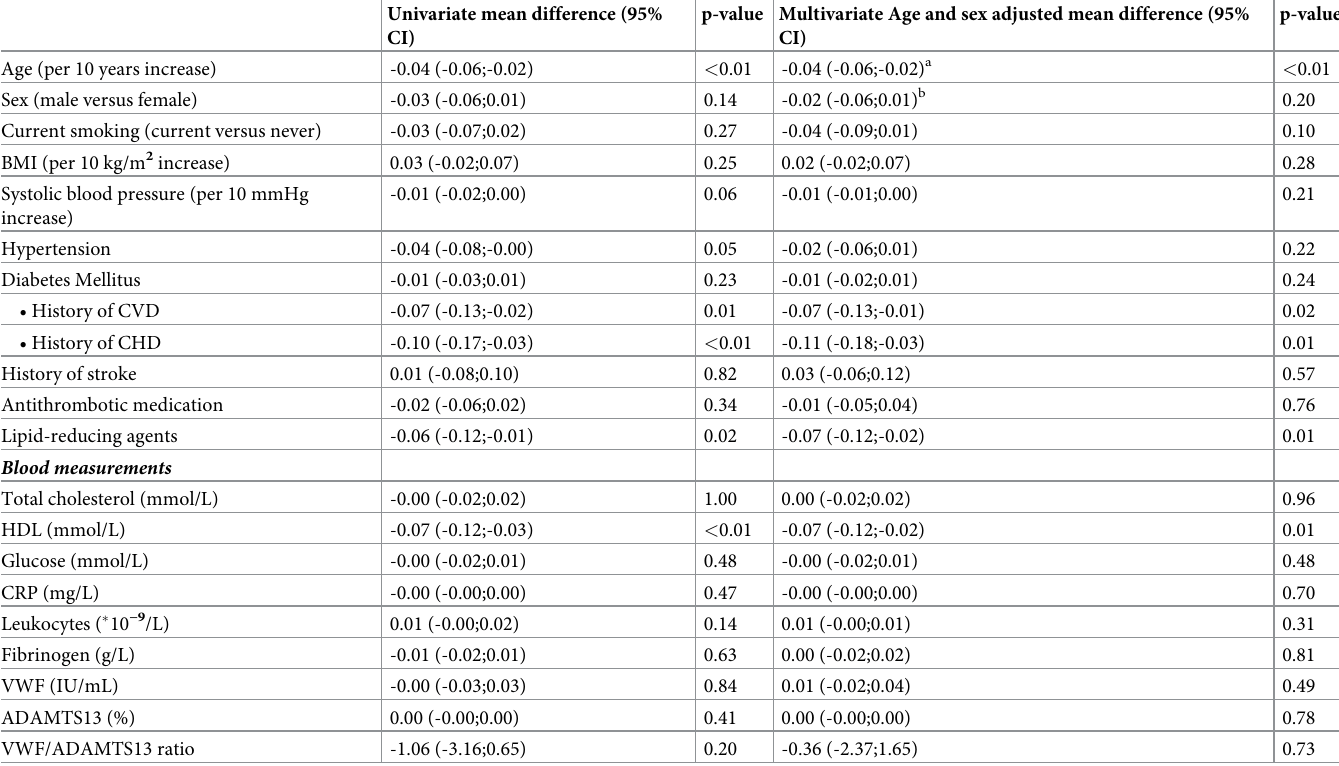
Table 2. Associations between MPO-DNA complex levels and clinical